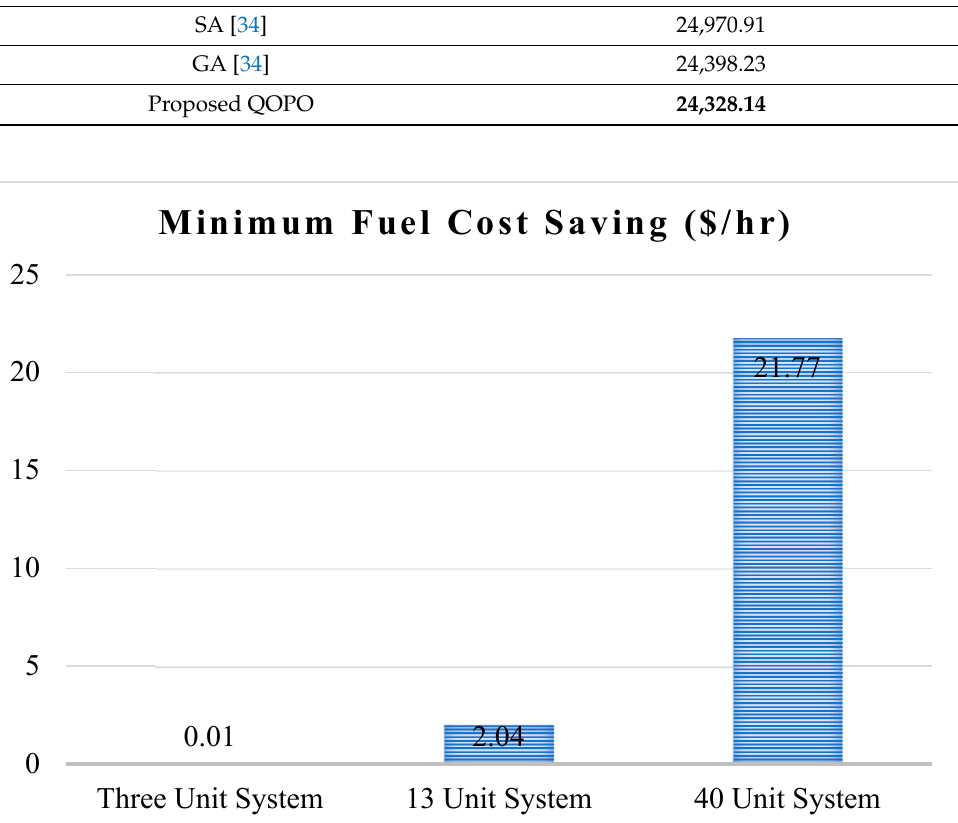
Figure 2. Minimum saving of fuel cost using QOPO when compared to other techniques with an increase in generating units.